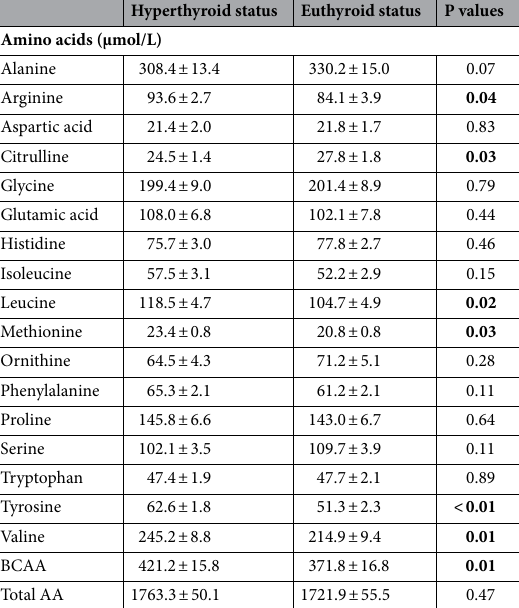
Hyperthyroid status Euthyroid status P